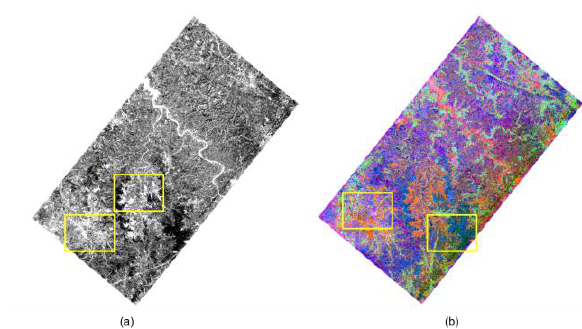
Figure 5. DESIS datasets (a) IC 3 (b) IC Indices R=2 G=3 B=4 In contrast, in Figure 4(b), MNF Indices R=3 G=9 B=7, areas with basalts are matched in pink and blue. ICA is applied on DESIS datasets, and IC component 3 and indices consisting of IC components as R=2 G=3 B=4 are shown in Figure 5. These results support PCA and MNF results on DESIS data in interpreting the minerals like muscovite, granite, and mostly basalts. Figure 5(a) shows the bright patches in the yellow box show the similarity with mica schist and basalt while in Figure 5(b) the blue and light green color on the bottom of the image shows basalt flow.